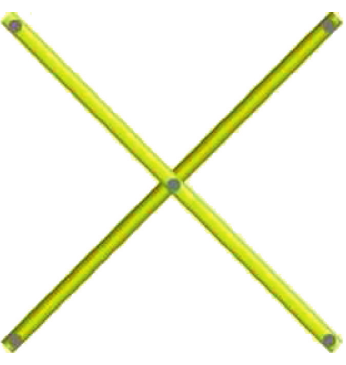
Figure 2: Scissor unit.